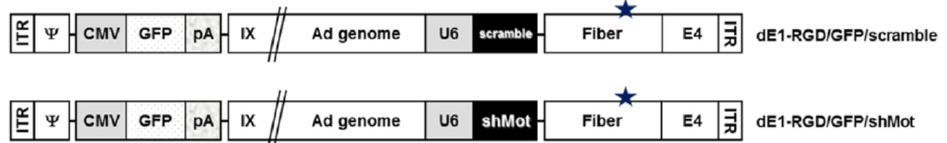
Figure 9. Schematics of the shMot-expressing adenoviral vectors. The RGD-incorporated adenoviruses were generated by inserting the RGD motif between HI loop of the fiber knob (star). (ITR = inverted terminal repeat; Ψ = packaging signal; pA = polyA sequence; IX = protein IX; shMot = mortalin-specific small hairpin (sh)RNAs).